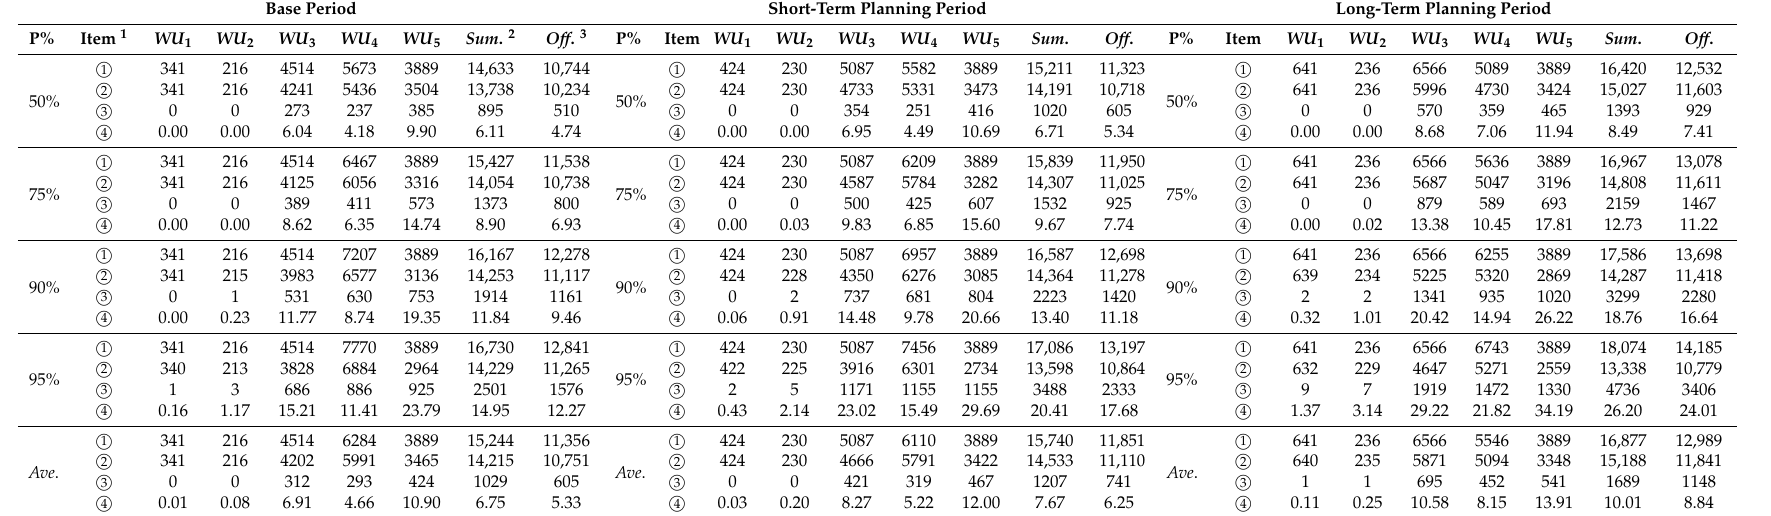
Table 4. Water balance between water supply and demand for the middle and lower reaches of Hanjiang River basin under different water demand scenarios. Base Period Short-Term Planning